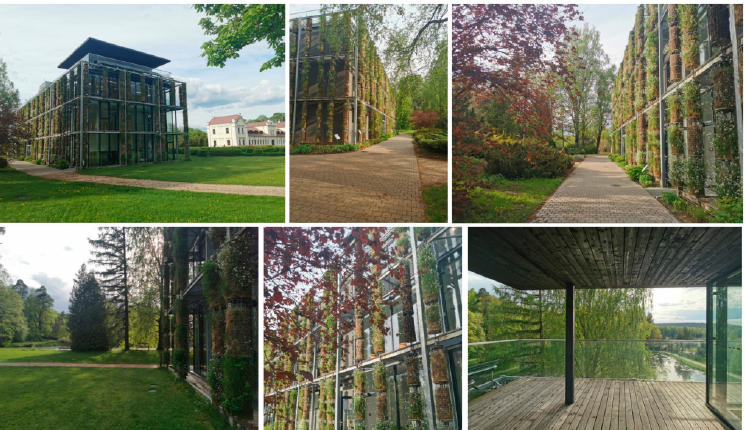
Figure 3. Vilnius University Kairenai Botanical Garden’s Green Building-Plant with external layer of vegetation was selected as an example of applied biophilic design. Photographs by A. Daugelaite.